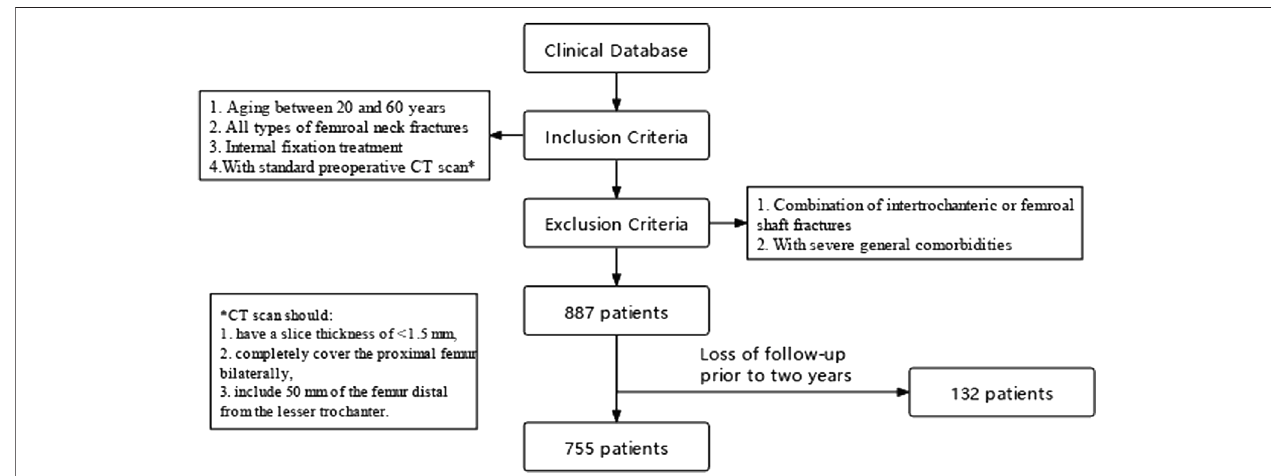
FIGURE 1 | Patient selection